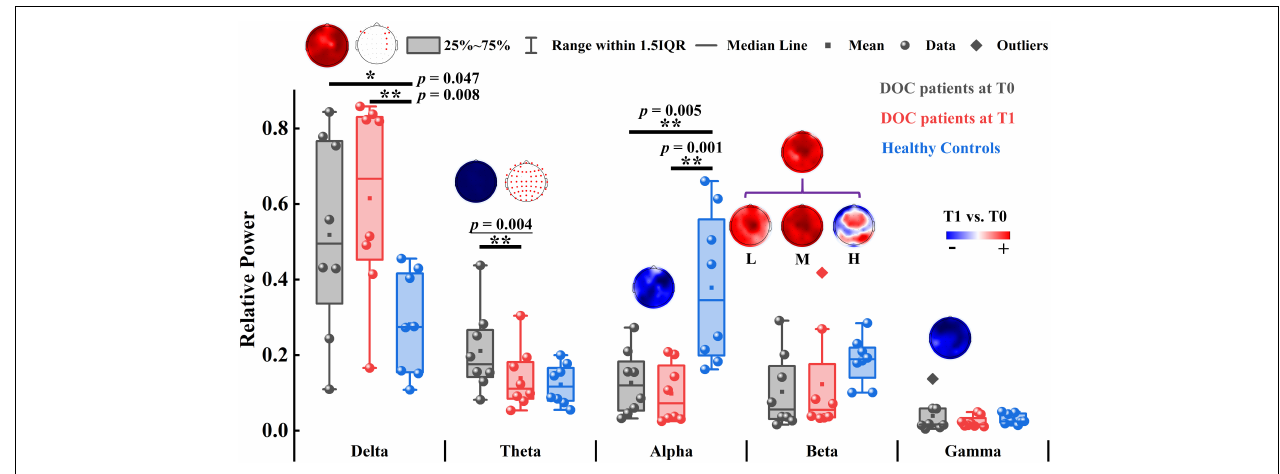
FIGURE 2 | The relative power of patients with DOC and healthy controls. The topographic map above the box plot shows the change in relative power at the channel level before and after zolpidem administration, and, if there is a significant difference, it is marked with a red dot in the other topographic map. Red and blue colors indicate higher and lower relative power for patients at T1 versus patients at T0, respectively. L, M, and H denote the low β -band, middle β -band, and high β -band, respectively. * p < 0.05, ** p < 0.01; p -value with an underline indicates the minimum obtainable p -value is